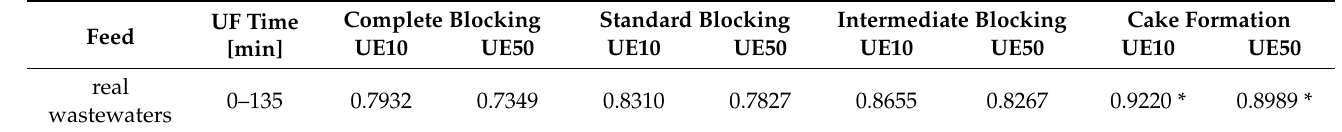
Table A6. Coefficient of determination (R 2 ) Hermia’s model. The UF process of real wastewater (Figure